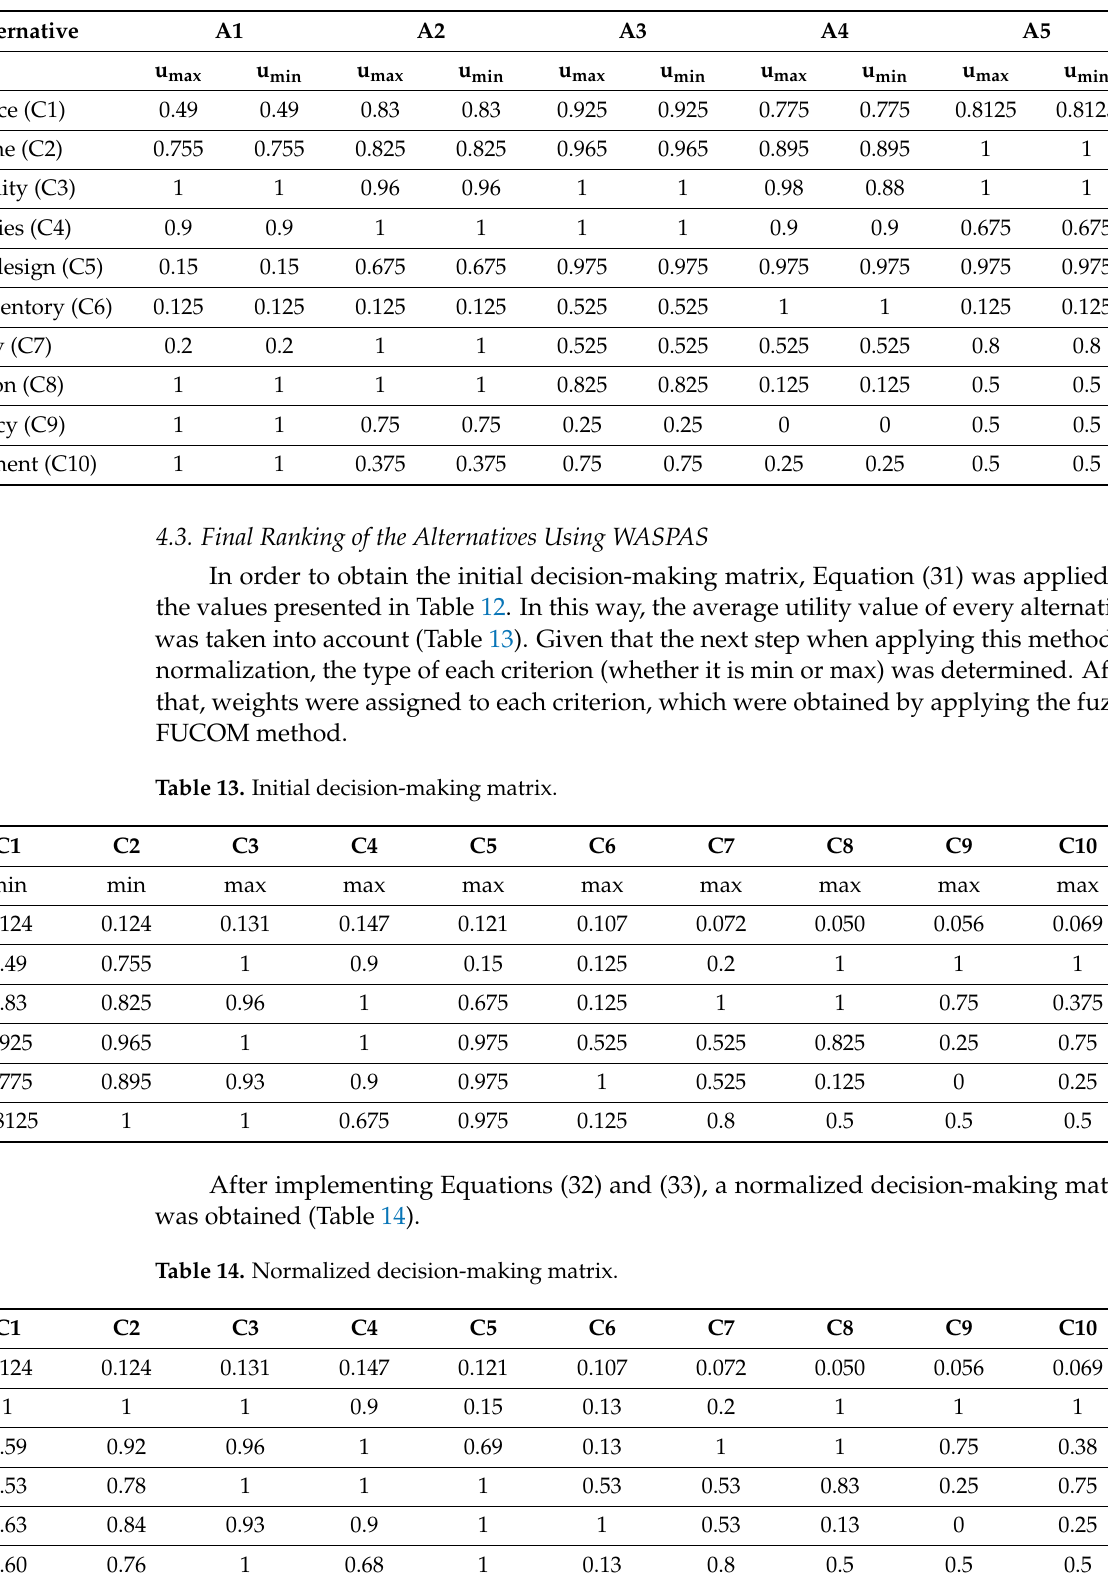
Table 12. Utility intervals.